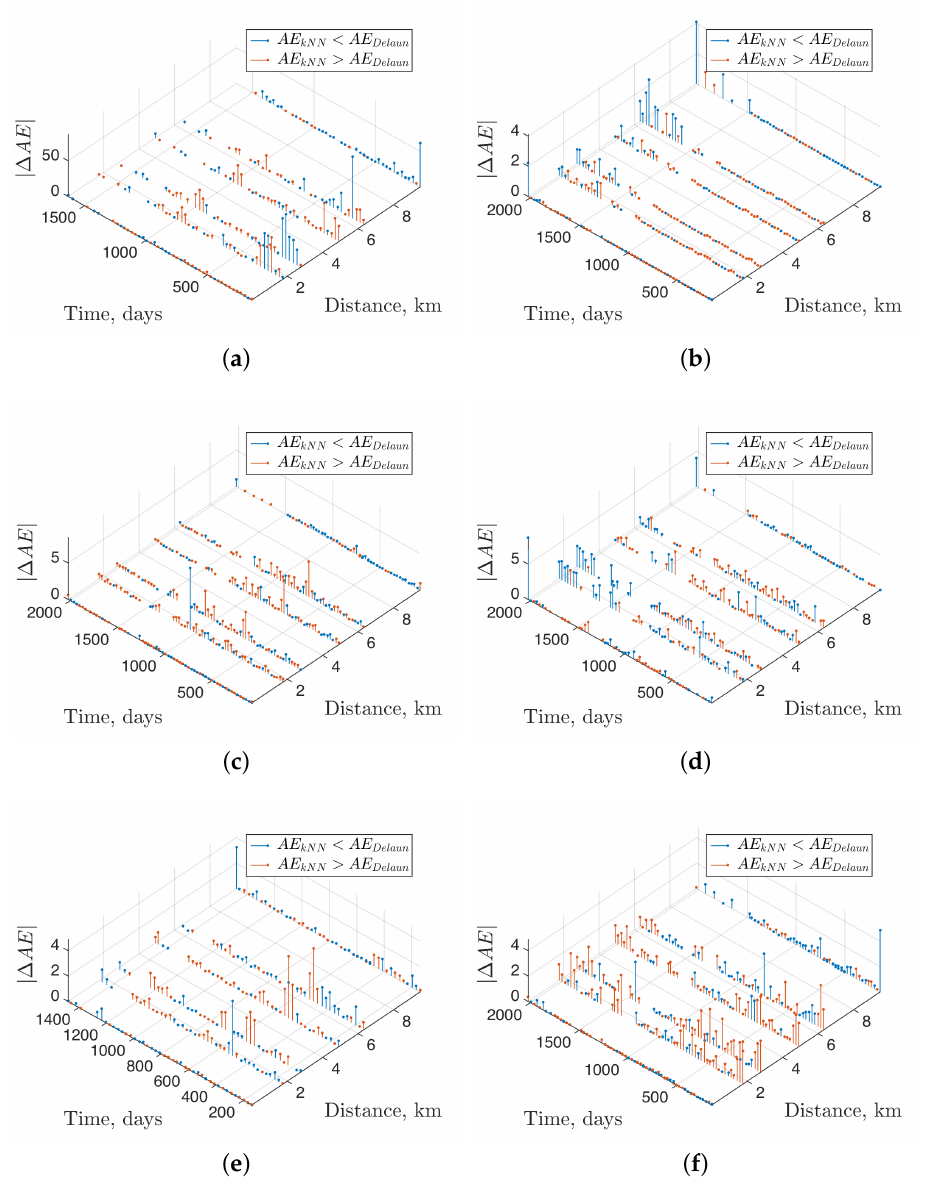
Figure 7. Spatio-temporal distributions for | ∆ AE | = | AE kNN − AE Delaun | : ( a ) O&F; ( b ) DET; ( c ) BOD/COD; ( d ) DO; ( e ) NO 3 ; and ( f ) PO 4